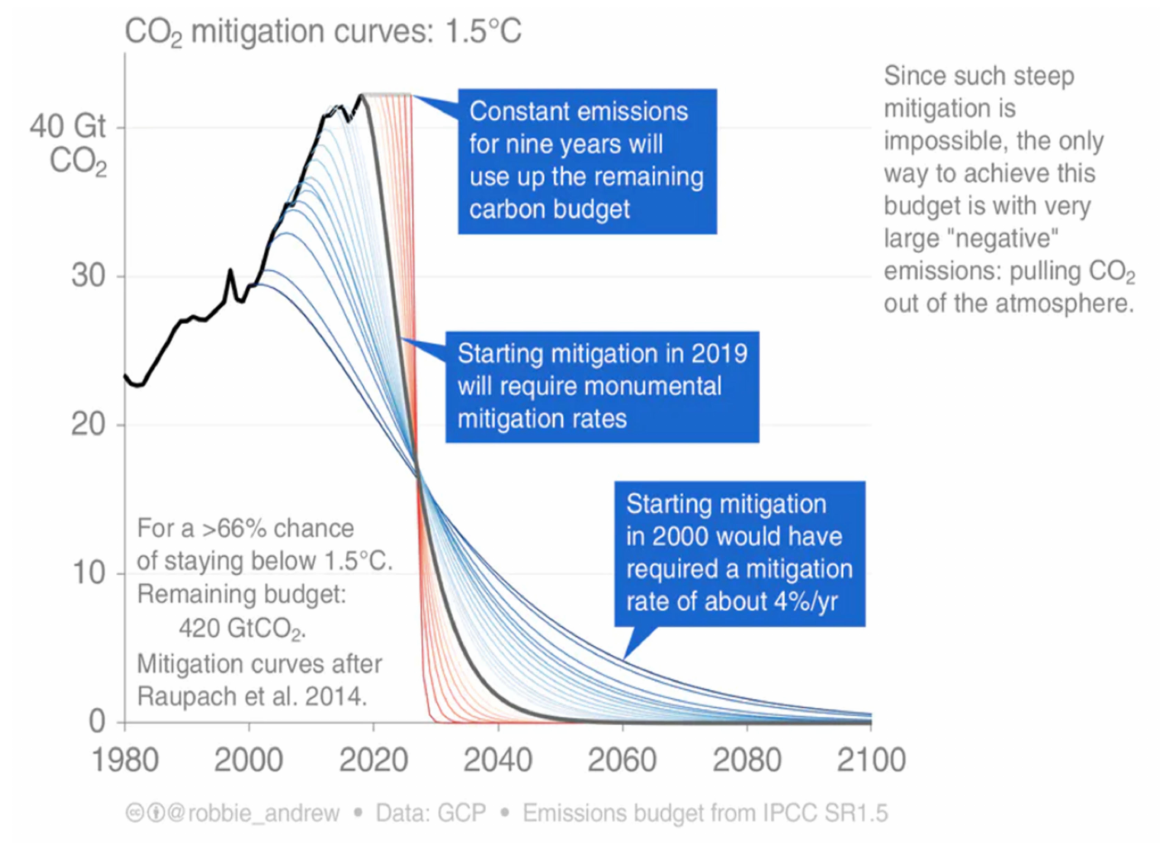
Figure 5. Graph demonstrating how fast CO 2 reductions must happen to stay below a 1.5 K increase [74]. Reproduced with permission from © Robbie